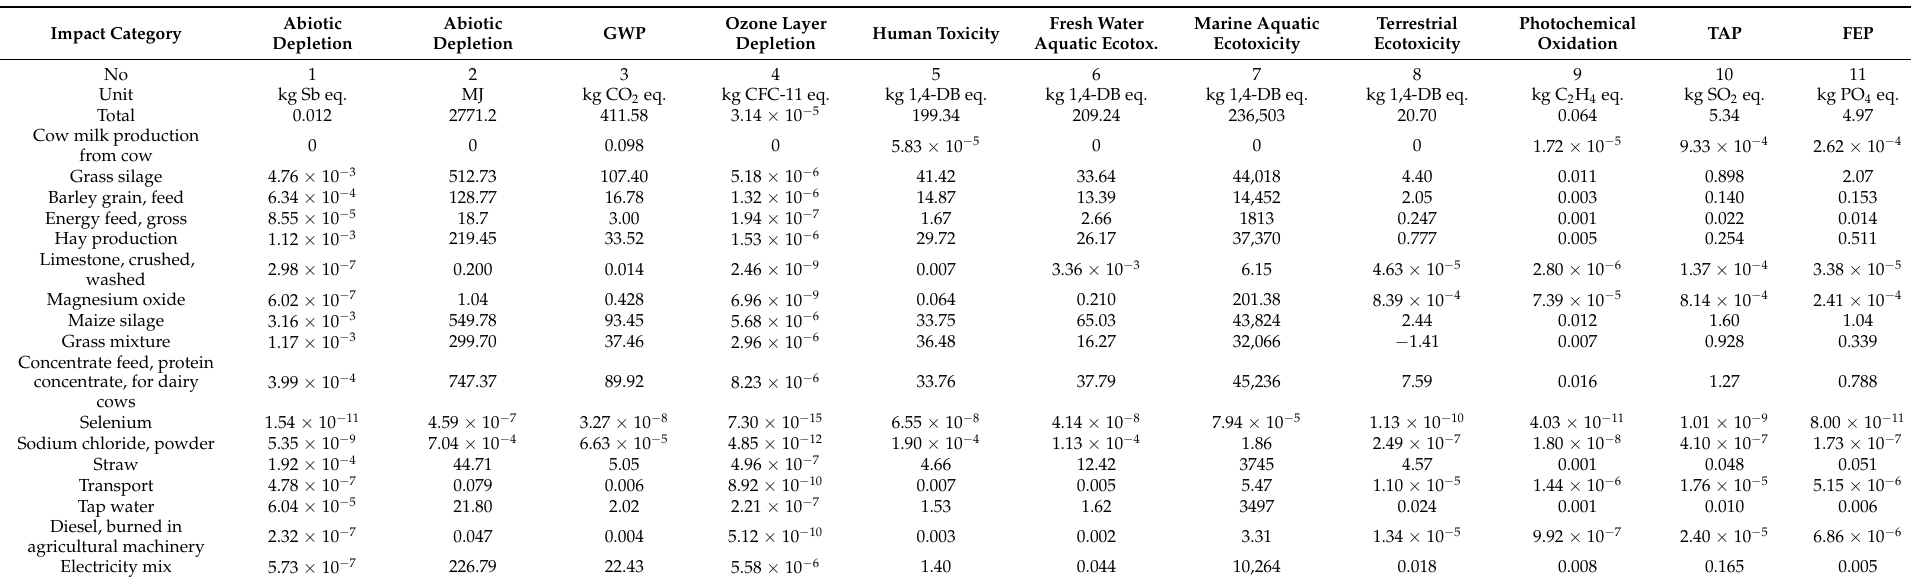
Table 2. Results of Classic SC management and milk production (for 1 FU = 1000 kg of